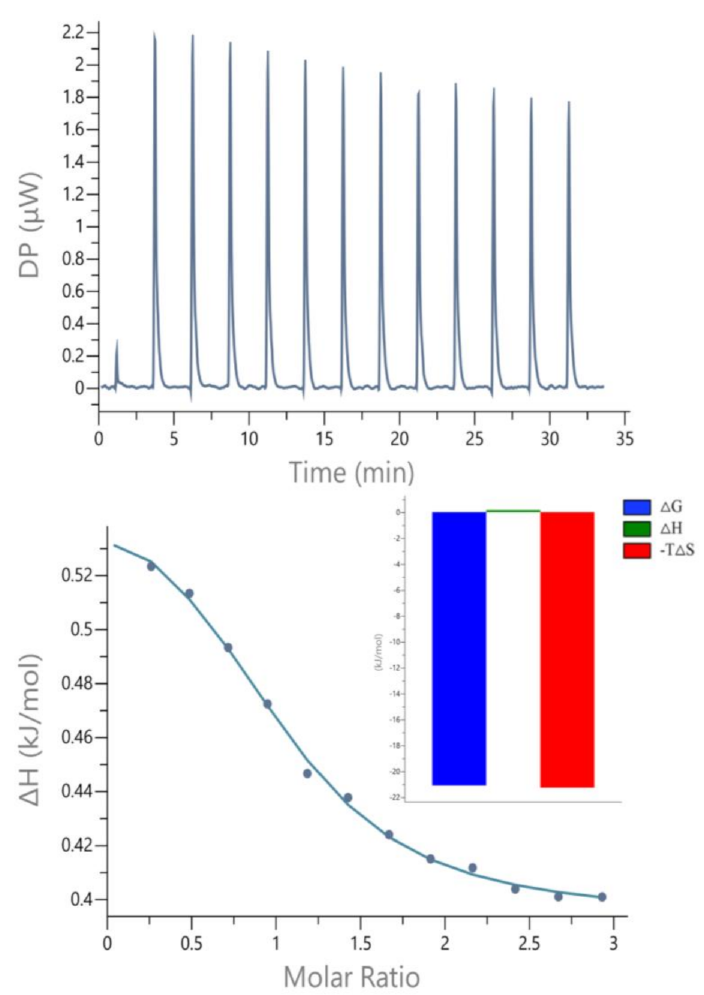
Figure 4. ITC profiles of the interaction between IND with SOD. Experimental conditions: